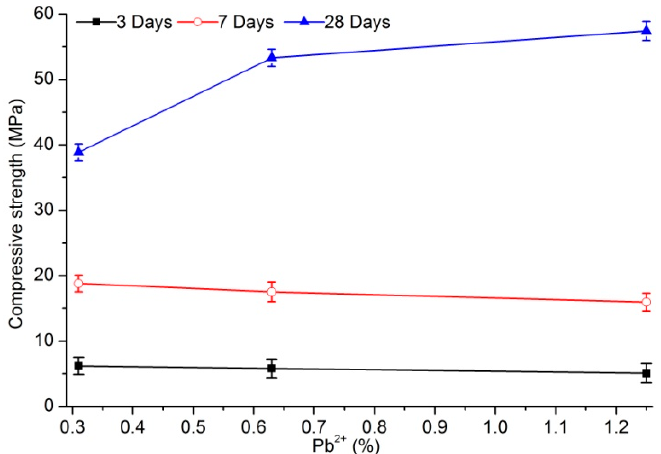
Figure 2. Compressive strength of samples cured with phosphorus-slag-based cementitious pastes (PS).